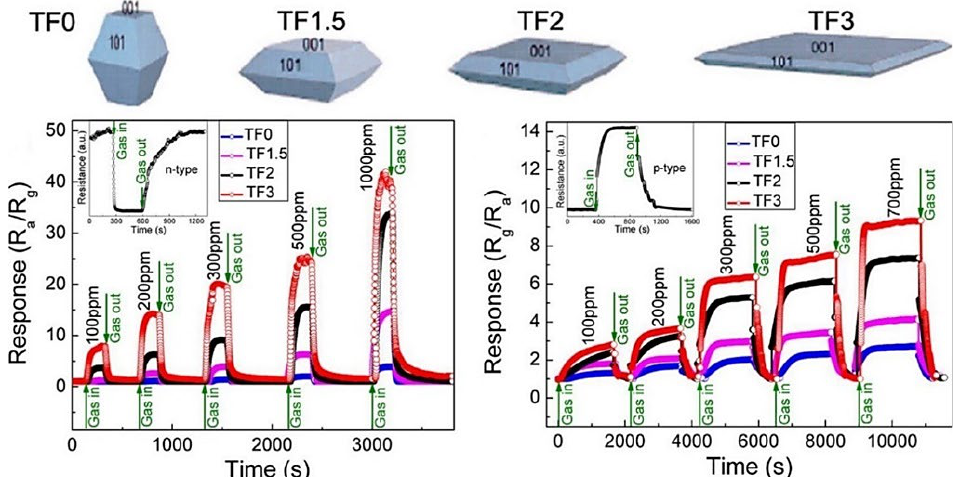
Figure 25. Both p-type and n-type sensing responses are revealed to be facet-dependent, demonstrating an obvious increase in response with increasing {001} percentage. Reprint from [140].